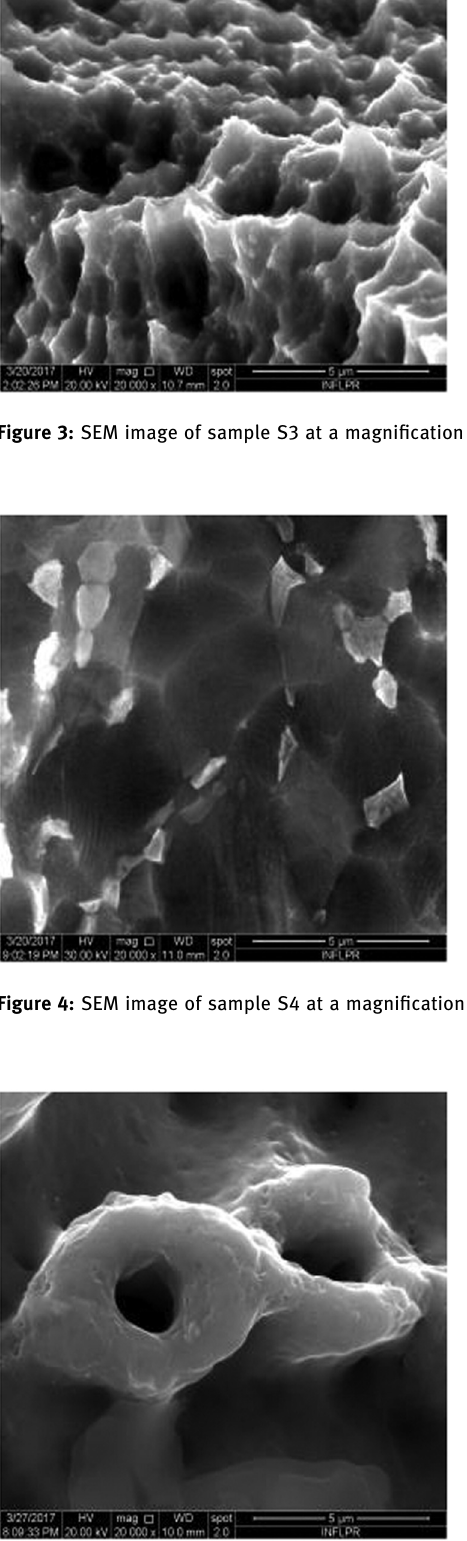
Figure 5: SEM image of sample S5 at a magni fi cation of 20k ×